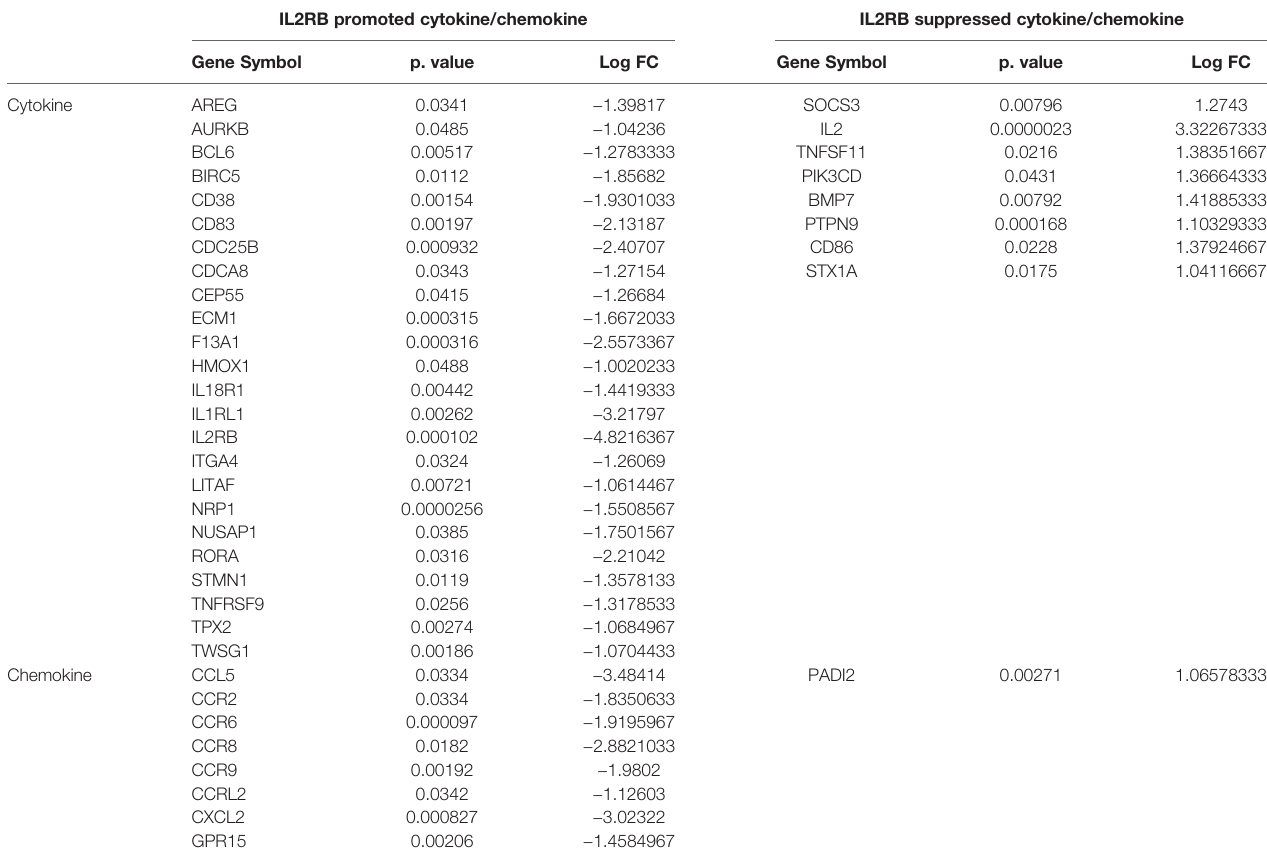
TABLE 8D | Twenty-four cytokines out of total 1,176 cytokines and cytokine receptors and eight chemokines out of 199 chemokines according to HPA database (https://www.proteinatlas.org/search/cytokine; https://www.proteinatlas.org/search/chemokine) were promoted by IL2RB in Treg; eight cytokines and one chemokine were suppressed by IL2RB in Treg.